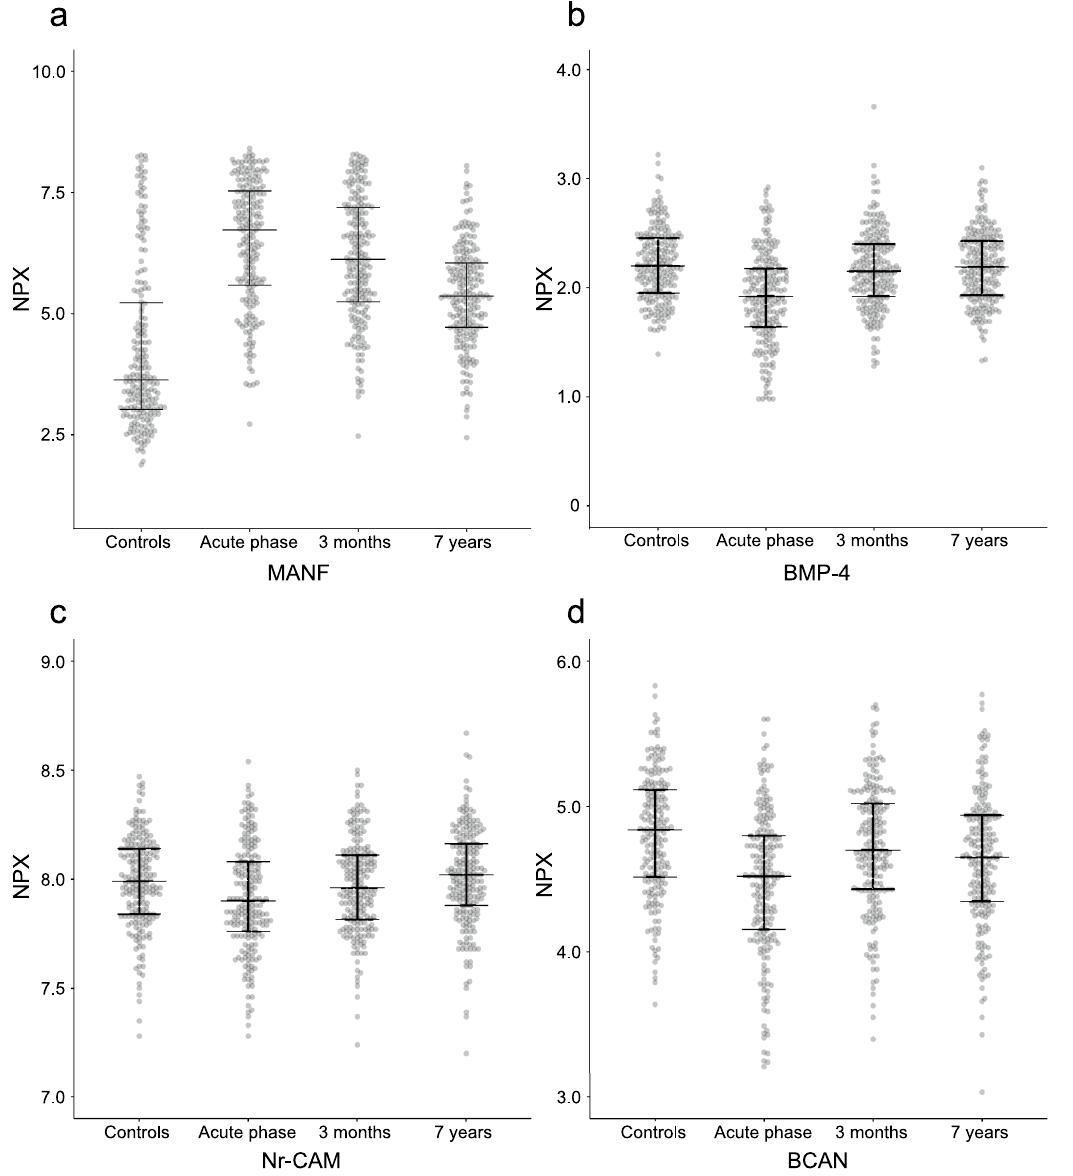
Figure 3. Selected temporal patterns of plasma proteins levels. Distribution as well as median and interquartile range of protein levels according to Normalized Protein eXpression (NPX) levels. Each dot represents one individual sample. ( a ) The first temporal pattern is represented by Mesencephalic astrocyte-derived neurotrophic factor (MANF), where higher plasma levels in ischemic stroke cases than controls are noted in the acute phase followed by a subsequent decrease over time in cases ( p < 10 −4 , FDR < 10 −4 for difference throughout). ( b ) The second pattern is represented by Bone morphogenetic protein 4 (BMP-4), where lower levels are observed in the acute stroke phase ( p = 1.18 × 10 −14 , FDR = 1.54 × 10 −13 for difference vs. control levels, and p = 7.30 × 10 −16 , FDR = 3.16 × 10 −15 compared to 3-month levels), followed by a subsequent normalization at 3-months and thereafter ( p > 0.20 throughout). ( c ) Temporal patterns for Neuronal cell adhesion molecule (Nr-CAM) and ( d ) Brevican core protein (BCAN). For both Nr-CAM and BCAN, levels were statistically significantly altered in the acute stroke phase compared to controls, and between follow-up evaluations within cases ( p < 0.001, FDR < 0.01